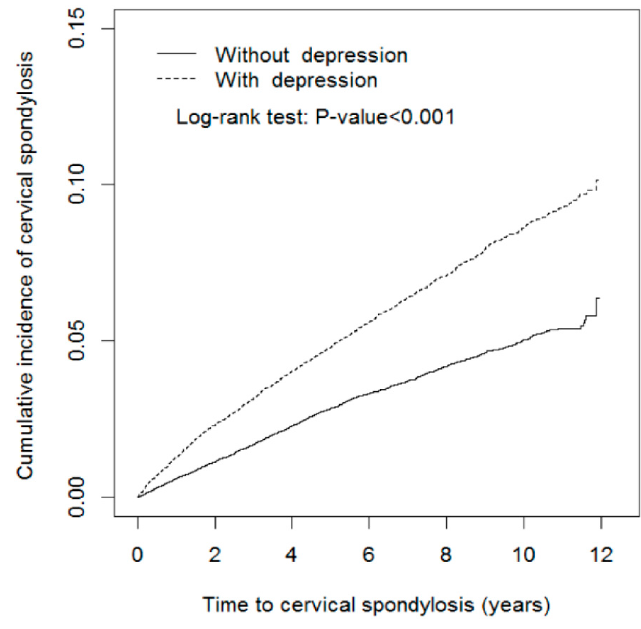
Figure 2. Cumulative incidence of cervical spondylosis in cohorts with and without depression.